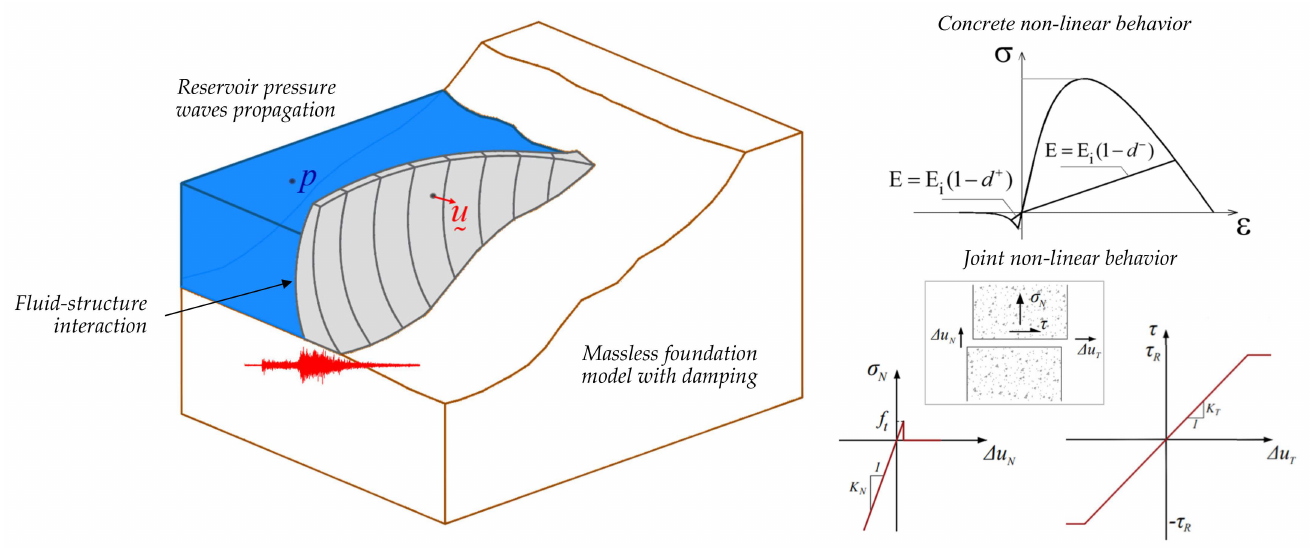
Figure 1. Representation of an arch dam–reservoir-foundation system. Possible interaction effects for non-linear dynamic